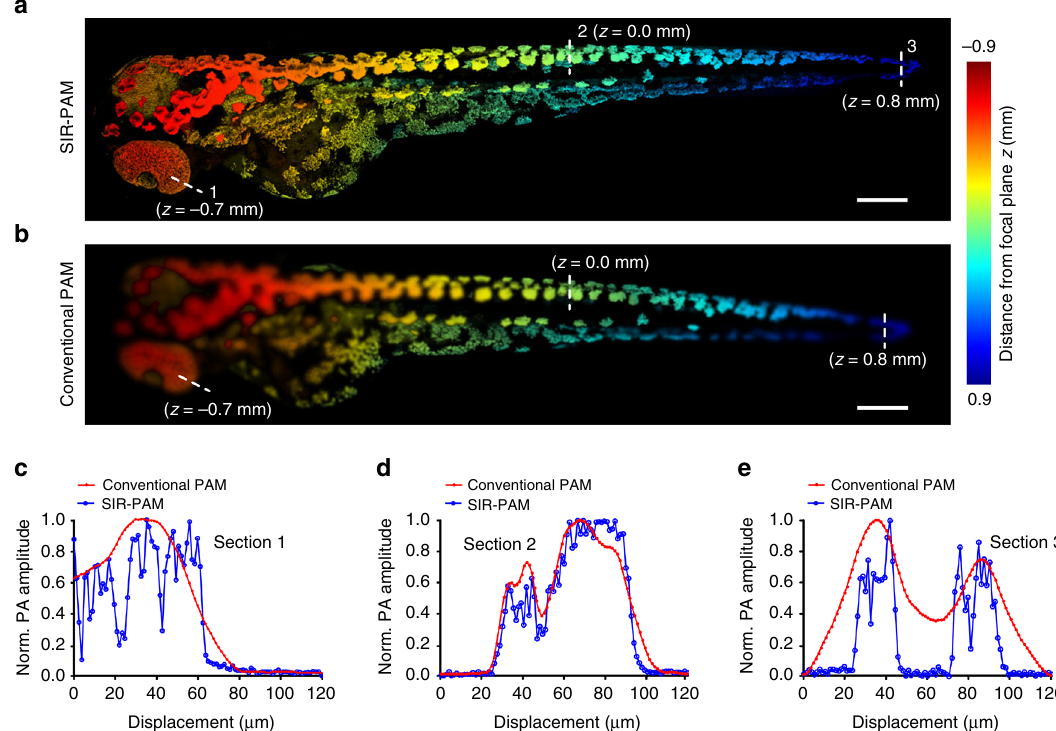
Fig. 5 SIR-PAM imaging of zebra fi sh embryos in vivo. a , b Depth-encoded whole-body images of a zebra fi sh larva obtained by SIR-PAM a and conventional PAM b . The focal plane is located at z = 0.0 mm. c − e Normalized PA amplitude pro fi les along the dashed lines. Finer structures can be resolved by SIR-PAM due to its improved lateral resolution within a large RIAR. Scale bars , 200 µ